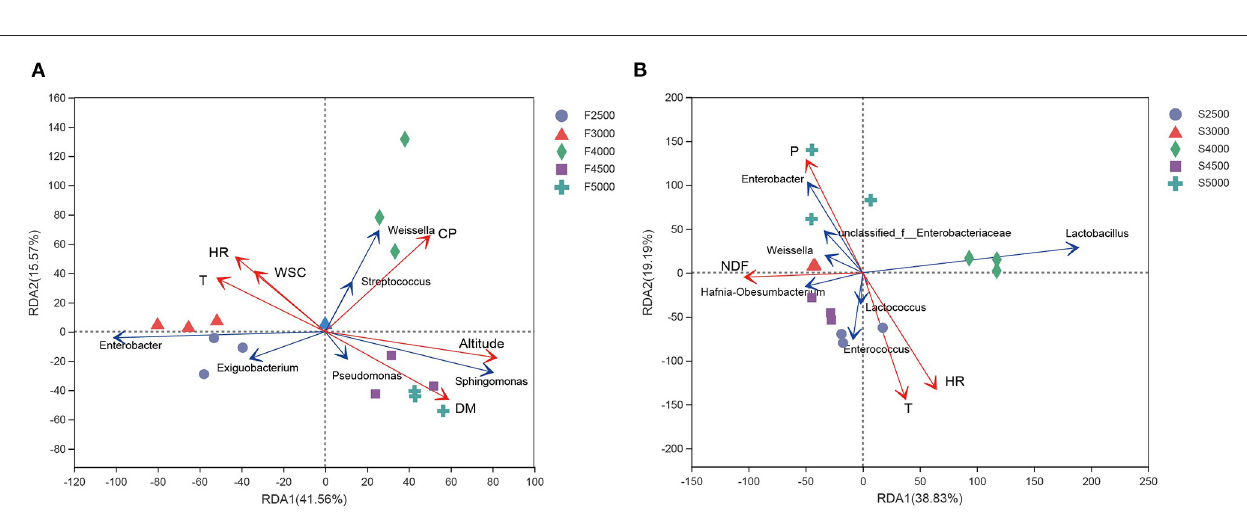
FIGURE 3 | Redundancy analysis of environmental factors and bacterial community of fresh (A) and ensiled (B) K. pygmaea along the elevation gradient on the Tibetan Plateau. The axes are labeled with the percentage of total variance explained (%). Red arrow lengts indicate the variance explained by environmental factors, and the blue arrow lengths indicate the variance explained by the bacterial community. T Individual samples are represented with circles, triangles, diamonds, squares, and cross. F2500, F3000, F4000, F4500, and F5000 represent samples of fresh K. pygmaea at corresponding altitude gradients. S2500, S3000, S4000, S4500, and S5000 represent samples of K. pygmaea silages at corresponding altitude gradients. T, temperature; HR, relative humidity; WSC, water-soluble carbohydrate; CP, crude protein; DM, dry matter; P, average precipitation; NDF, neutral detergent